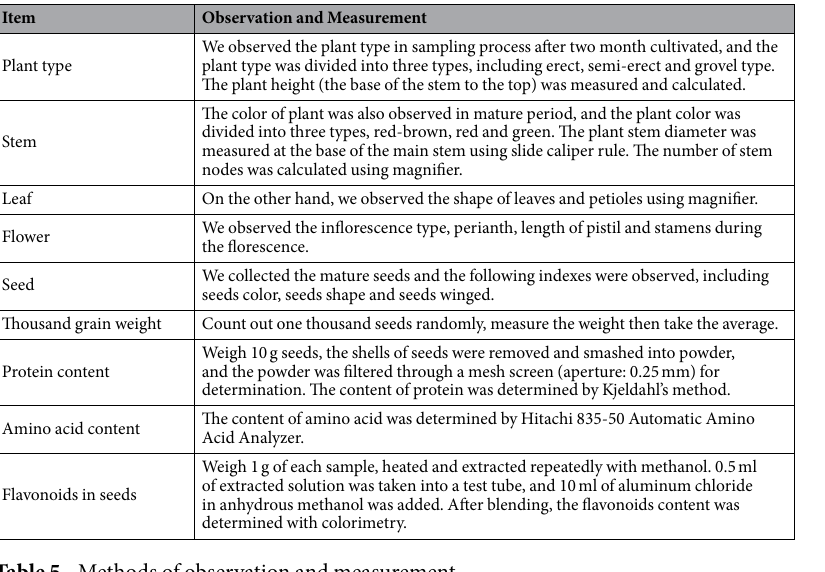
Table 5. Methods of observation and